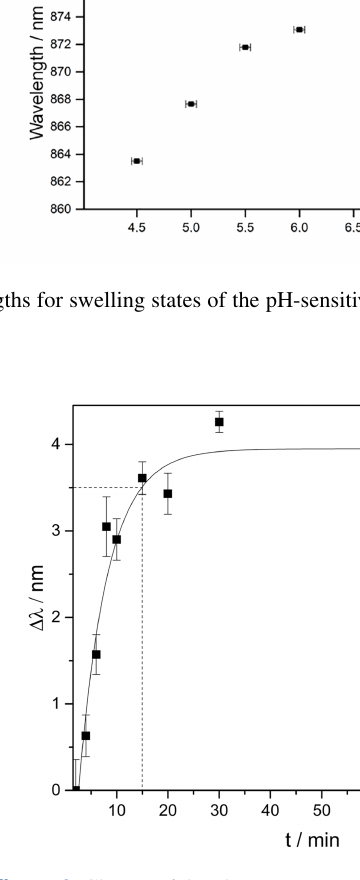
Figure 3. Change of the plasmon resonance wavelength induced by the hydrogel swelling in pH 4.5 after a pre-swelling in pH 6.5. From the fit a response time of 15min is derived after which the swelling reached 90% of the final steady-state value (indicated by the dashed